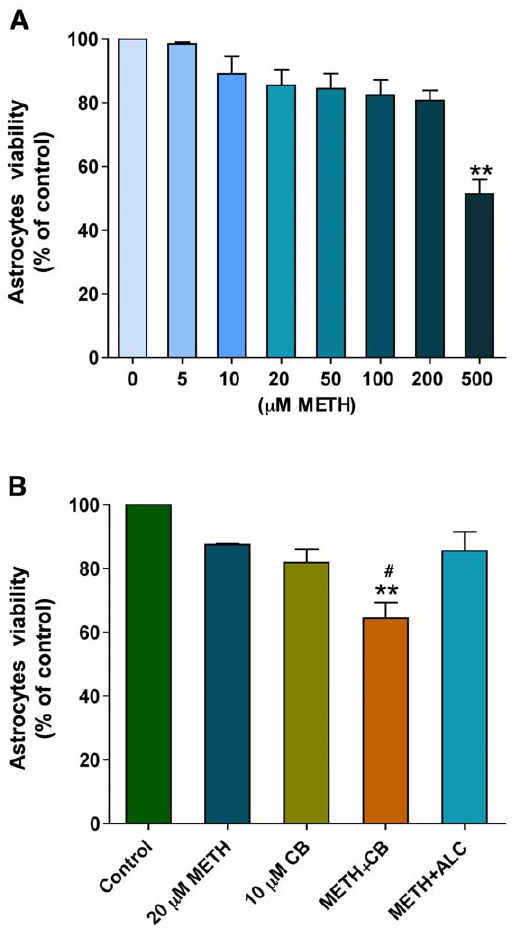
Figure 5. METH-induced glucose deprivation cause cell death in human astrocytes: A. Dose dependent effects of METH on cell viability in human at 24 hr. B. Cell viability assay of human astrocytes treated with 20 m M METH in presence or absence of cytochalasin B (10 m M) or ALC (100 m M) for 72 hr and compared with untreated cells. Statistically significant (n=5), **p , 0.01 compared with controls in A and B and # p , 0.05 with 20 m M METH or 10 m M cytochalasin B in B .